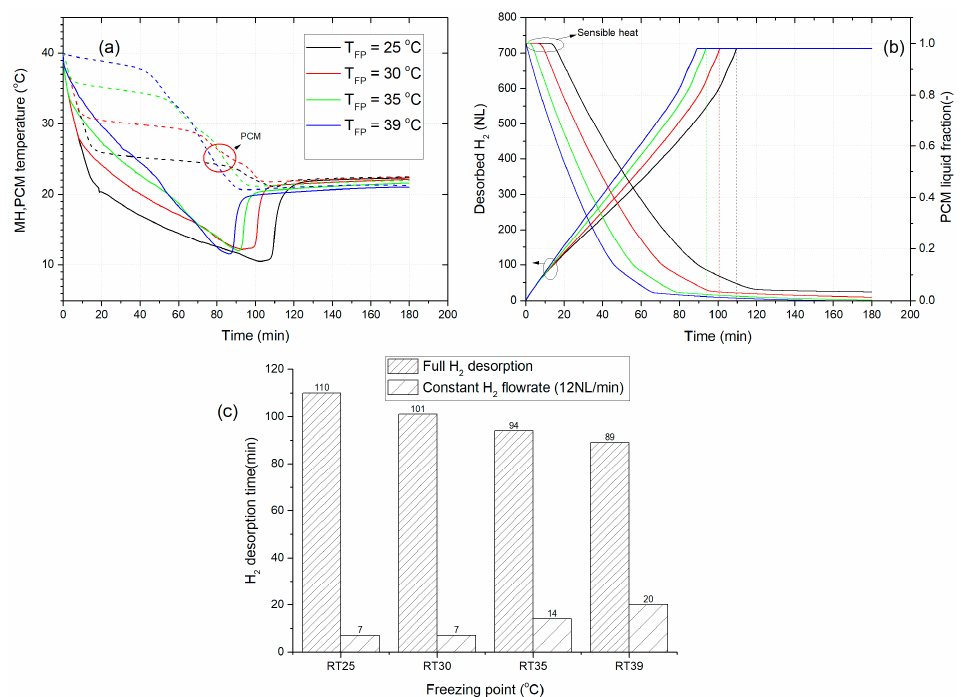
Figure 5. ( a ) Temporal variation of the average MH and PCM temperature, ( b ) temporal profile of PCM liquid fraction and the H 2 volume desorbed (dotted lines mark the time required for the completion of dehydrogenation process), and ( c ) dehydrogenation time.